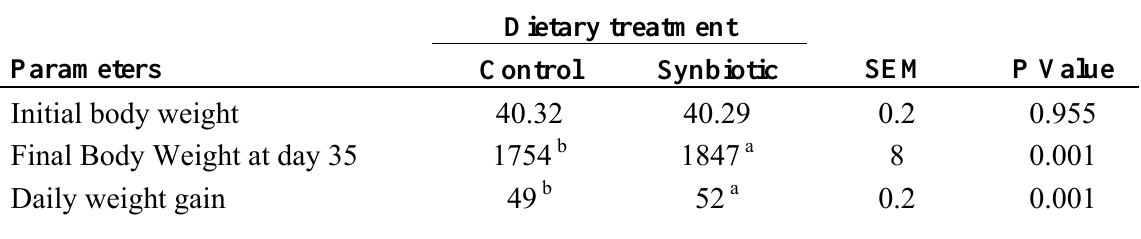
Table 2. Effects of dietary inclusion of synbiotic on performance of broilers.